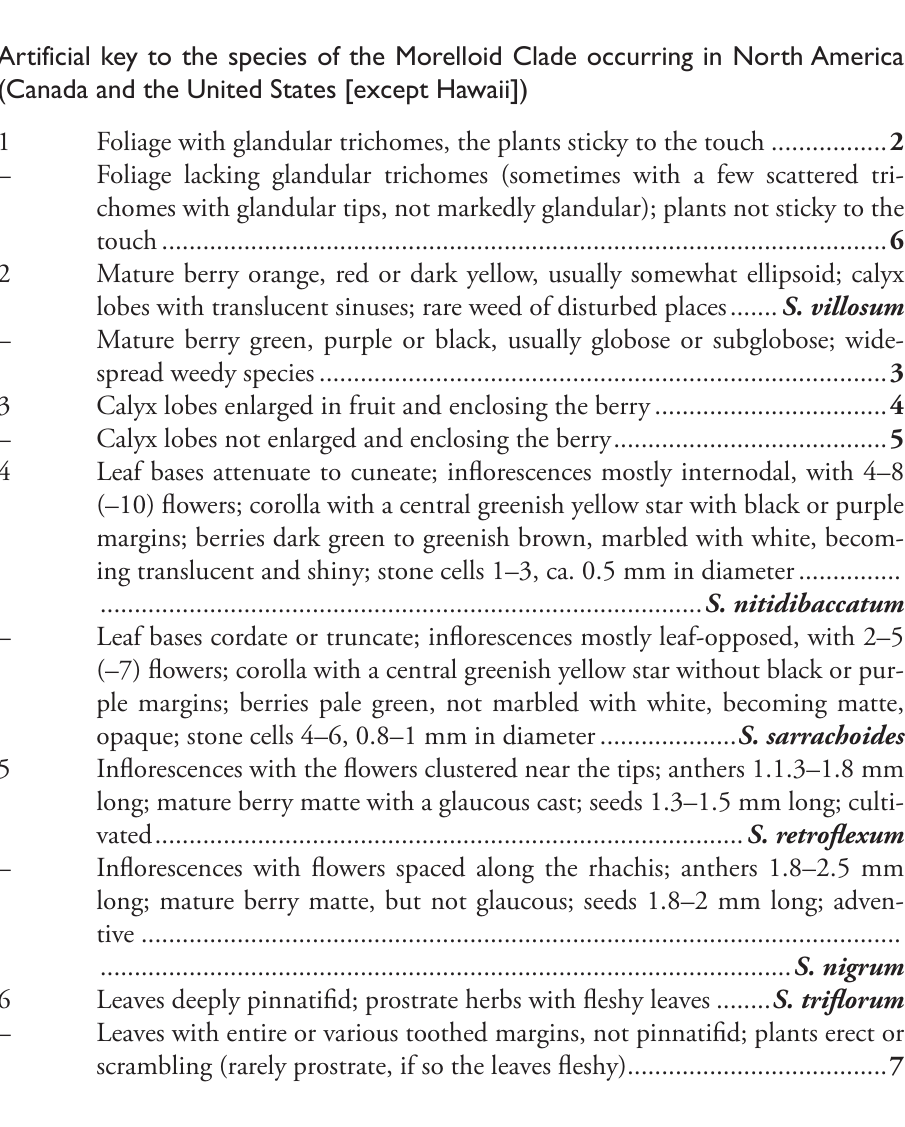
Anthers 1.2–1.5 mm long, almost globose; berry very shiny; widespread ...... ............................................................................................ S. americanum – Anthers more than 2 mm long, ellipsoid; berry matte or somewhat shiny, not very shiny; southeastern United States of America and the Caribbean ......... 3 3 Stone cells absent in mature berries; calyx lobes obovate; styles exserted to 2.5 mm beyond the anther cone at anthesis; coastal dunes in southeastern United States of America ................................................................ S. pseudogracile – Stone cells (2)6–8 (or more) in each mature berry; calyx lobes deltate to broadly deltate; style exserted ca. 1 mm beyond the anther cone at anthesis; many forest and open habitats throughout the Caribbean ......... S. nigrescens